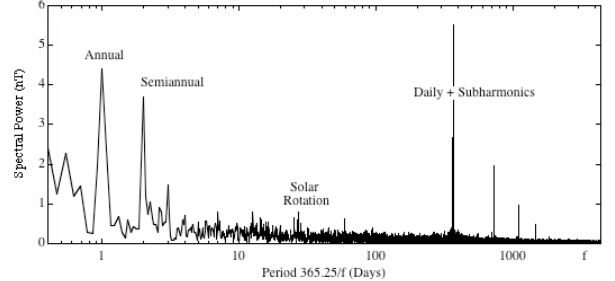
Fig. 5 Fig. 5. FFT-spectrum of the hourly horizontal field values ( 1H) at STP showing regular waves in annual, semiannual, solar rotation and daily variation with its subharmonics.